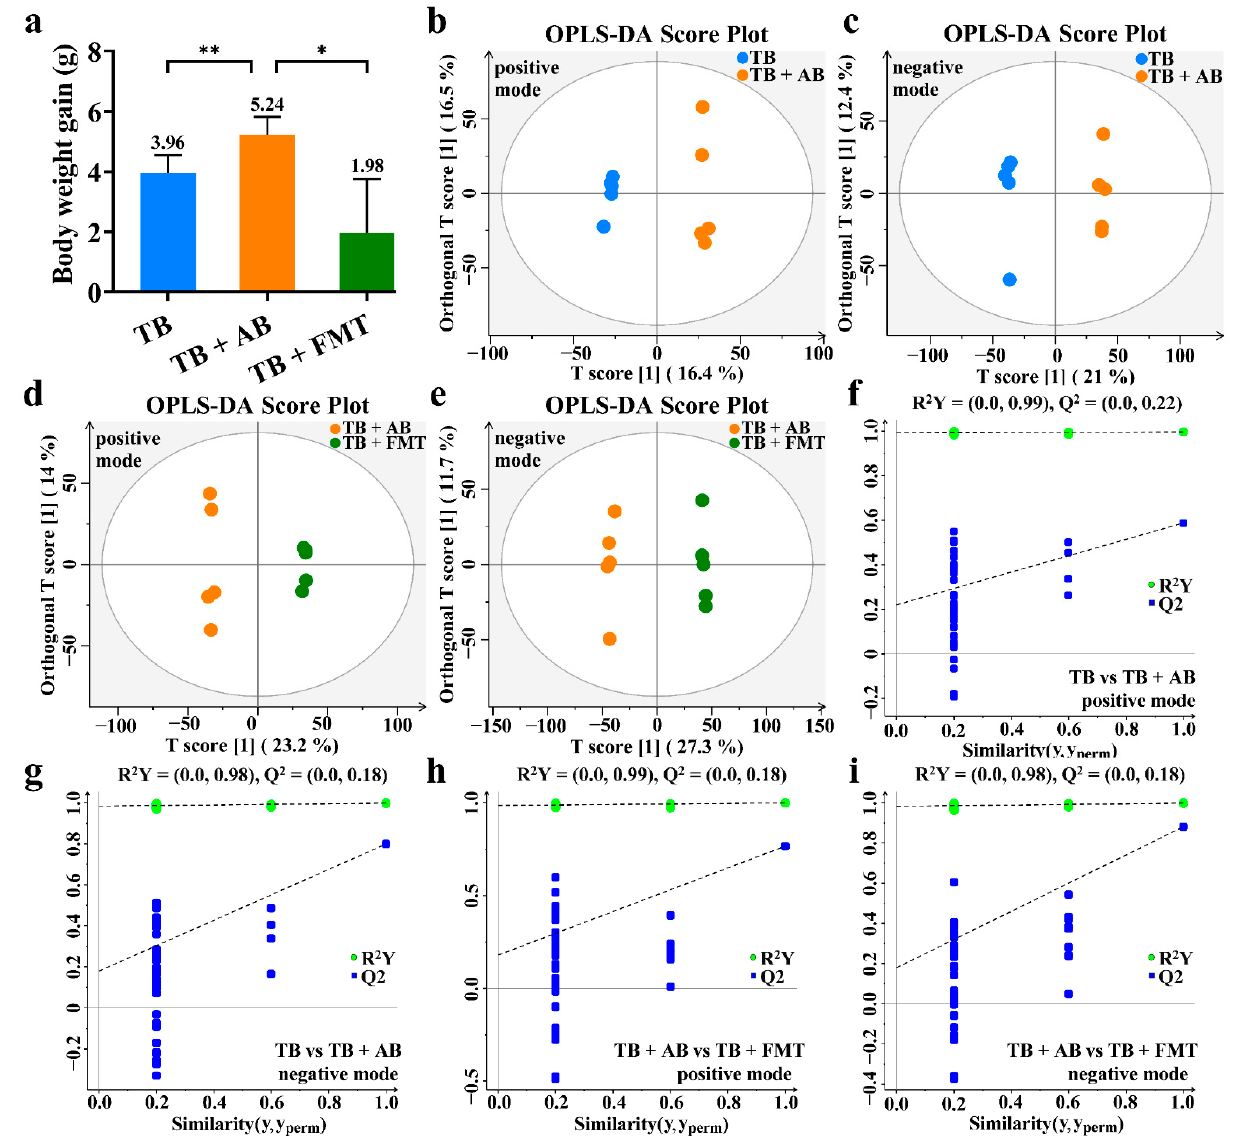
Figure 4. The body weight gain and the OPLS-DA of the untargeted metabolomics. ( a ) Body weight gain. ( b ) The OPLS-DA between the TB and TB + AB groups in the positive mode. ( c ) The OPLS-DA between the TB and TB + AB groups in the negative mode. ( d ) The OPLS-DA between the TB + AB and TB + FMT groups in the positive mode. ( e ) The OPLS-DA between the TB + AB and TB + FMT groups in the negative mode. ( f ) The permutation of OPLS-DA between the TB and TB + AB groups in the positive mode. ( g ) The permutation of OPLS-DA between the TB and TB + AB groups in the negative mode. ( h ) The permutation of OPLS-DA between the TB + AB and TB + FMT groups in the positive mode. ( i ) The permutation of OPLS-DA between the TB + AB and TB + FMT groups in the negative mode. Abbreviation: AB, antibiotics; FMT, fecal microbiota transplant; OPLS-DA, orthogonal partial least squares discriminant analysis; TB, theabrownin. * p -value < 0.05, ** p -value <